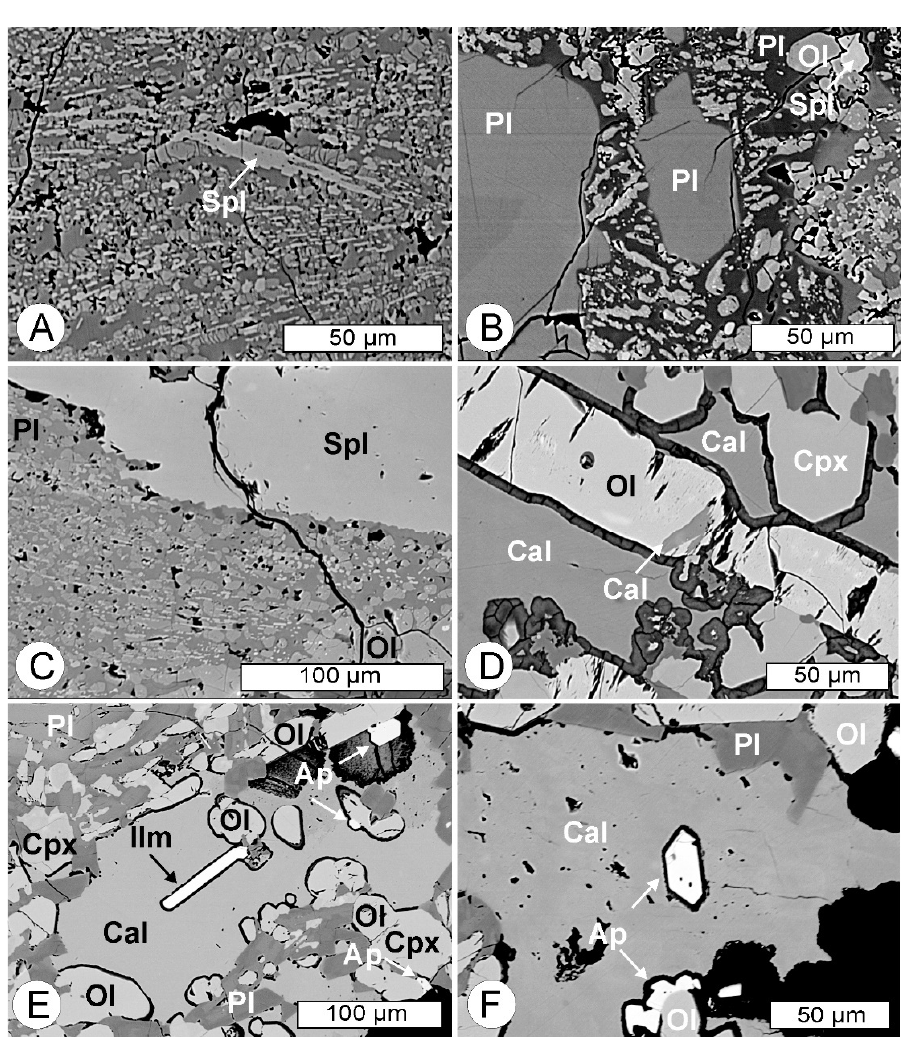
Figure 4. BSE images of rock-forming and superimposed minerals: ( A ) Enlarged view of pseudo- morph with elongated spinel aggregates (bright) and isometric olivine crystals (medium bright) embedded in dark plagioclase groundmass. Sample Ca-45; ( B ) Replacement of early basic plagio- clase with olivine, spinel and acidic plagioclase. Sample Ca-45; ( C ) Replacement of early spinel with olivine, spinel and acidic plagioclase. Sample Ca-45; ( D ) Columnar olivine II associated with carbonate growing across mafic layer composed of clinopyroxene I. Sample Cam-13; ( E )